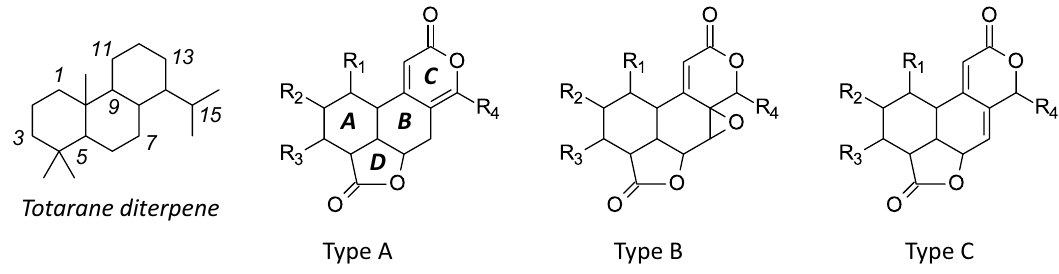
Fig. 2 The three chemical types of tetracyclic nagilactones. They differ by the organization of the conjugated lactone system in the B – C ring moiety. The numbering of the totarane diterpene nucleus is